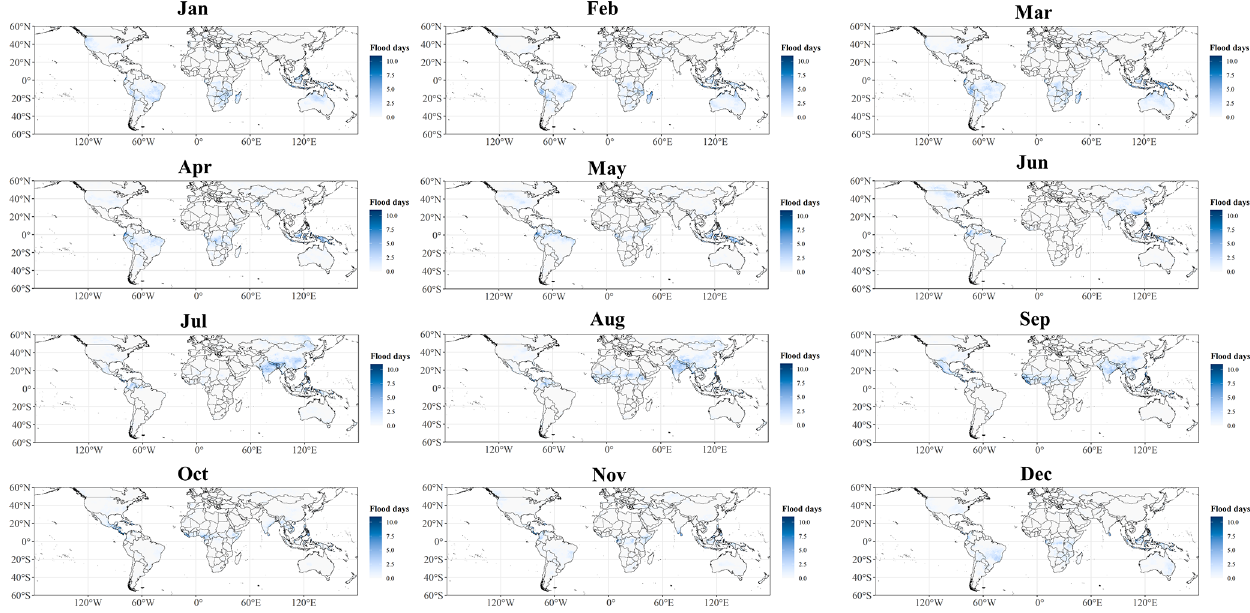
Figure 4. Average flood days in the same month of each year from 2002 to 2016.